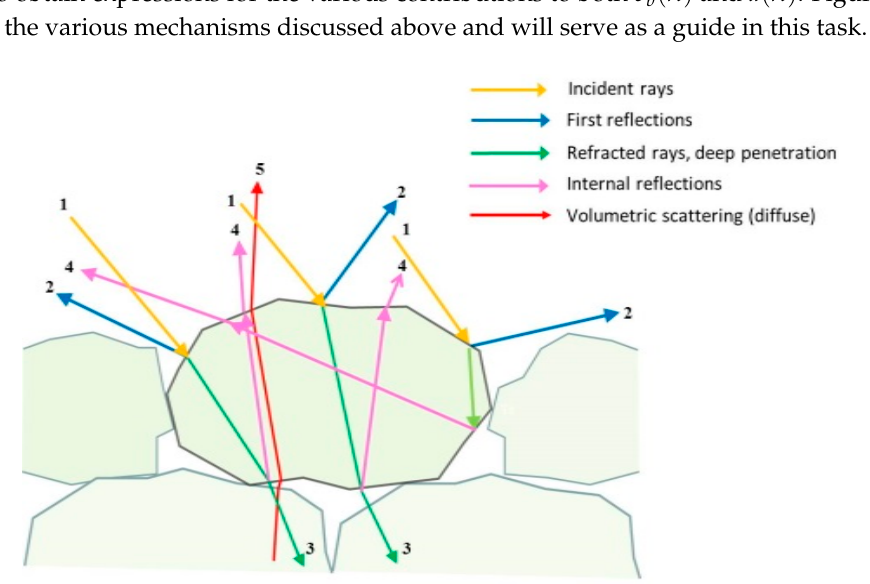
Figure 1. This figure is a schematic of the microstructure elements relevant to scattering and absorption for both minerals (grains) and vegetation (cells). The incident light rays (1) are reflected (2) and transmitted at the first surface (3). The rays transmitted through the first surface are subsequently both reflected back from the inner surfaces of the grains (4) and absorbed. The rays that penetrate deeper (5) are multiply scattered before coming back to the surface and have a near Lambertian (uniform) scattering distribution.